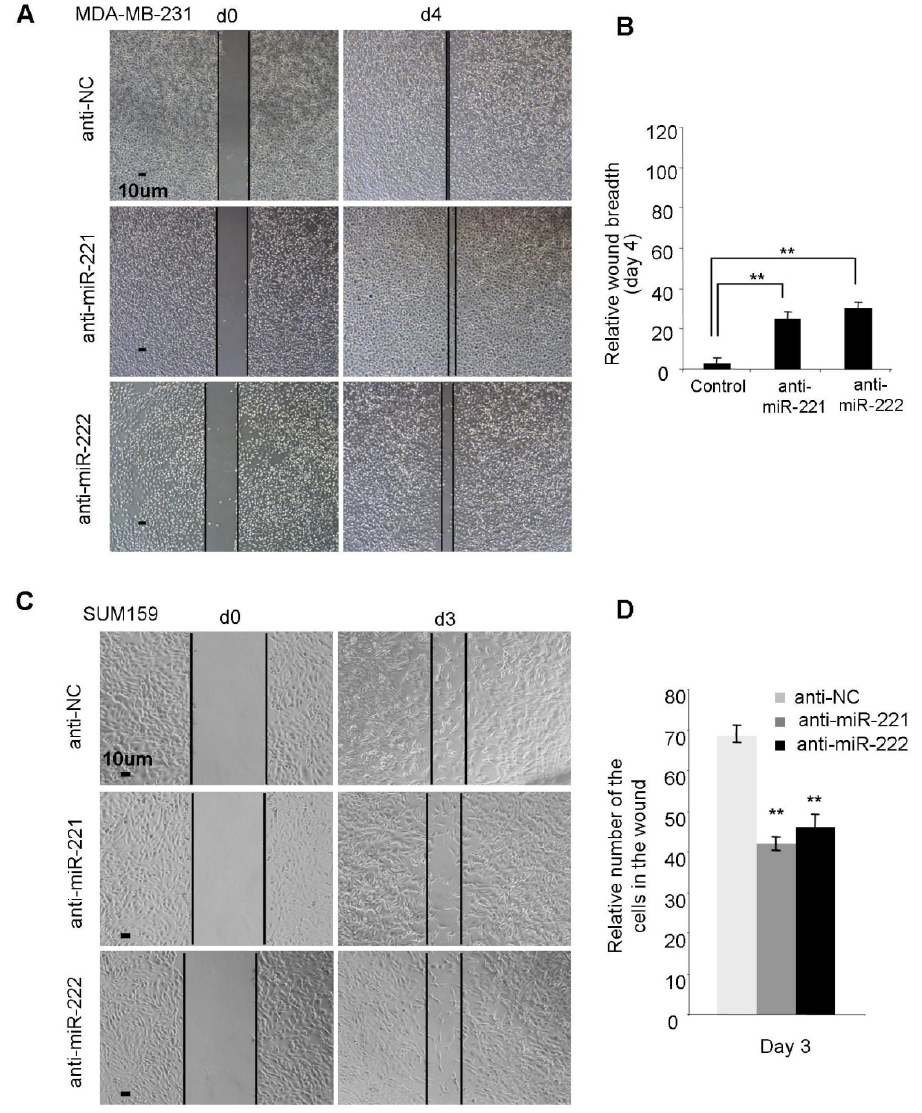
Figure 3. Anti-miR-221 and anti-miR-222 suppress cellular migration in BLBC cell